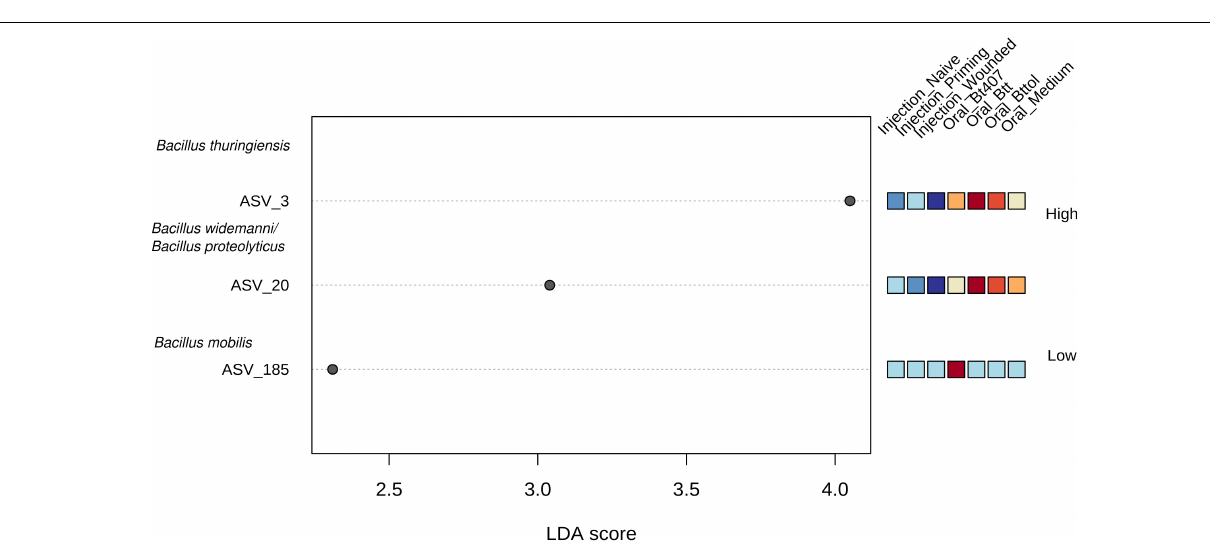
FIGURE 5 | Linear discriminant analysis effect size plot. Significant features are ranked in decreasing order by their LDA scores (x-axis). The heatmap to the right of the plot indicates whether the taxa are higher (red) or lower (blue) in each treatment. FDR < 0.05, LDA score > 2. Using BLAST all ASVs were identified as Bacillus